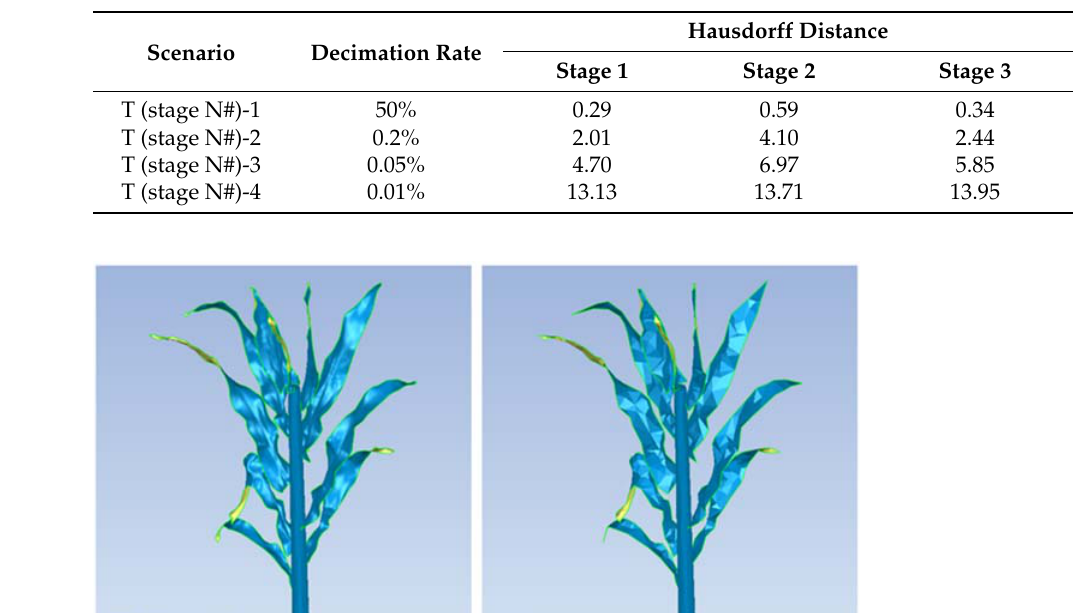
Table 2. The various scenarios chosen in the study.